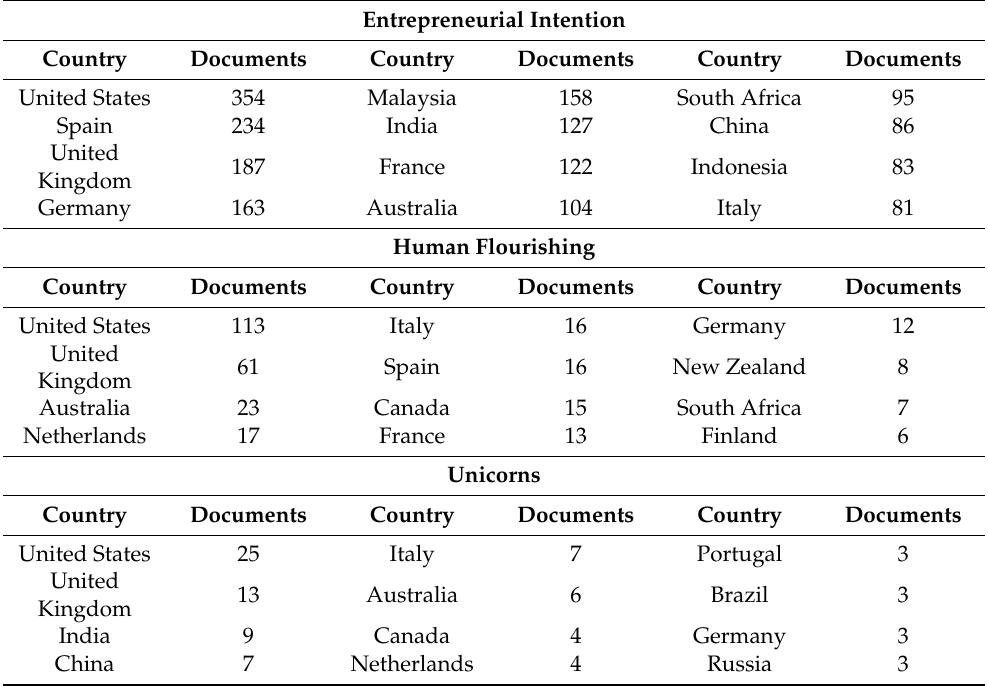
Table 1. Top countries for papers published on EI, HF, and unicorns, limited to the BMA and EEA subject areas (SCOPUS database between 2014 and